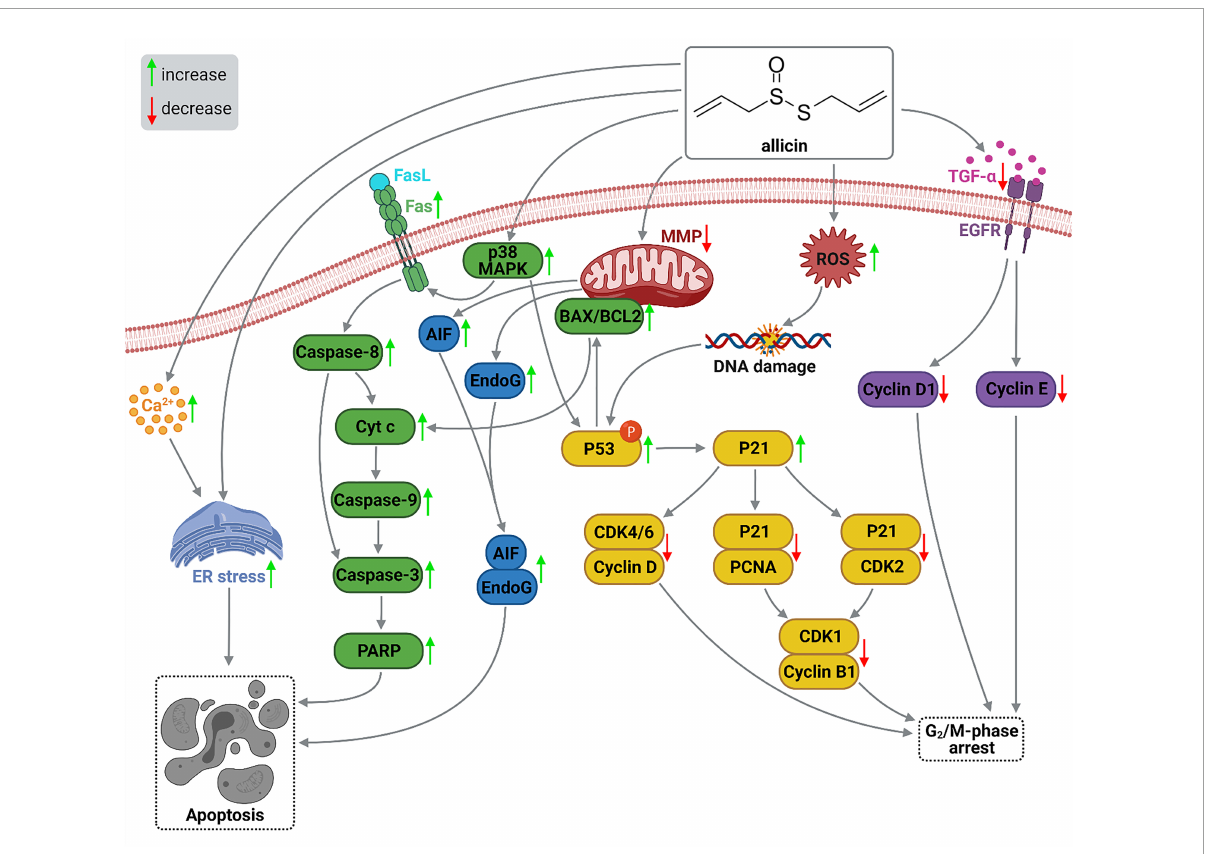
FIGURE3 Allicin-mediated apoptosis signaling pathways in gastric cancer cells. AIF, apoptosis induce factor; BAX, BCL2-associated X protein; BCL2, B-cell lymphoma 2 protein; CDK, cyclin-dependent kinase; Cyt c, cytochrome c; EGFR, epidermal growth factor receptor; EndoG, endonuclease G; ER, endoplasmic reticulum; Fas, apoptosis antigen 1 protein; FasL, Fas receptor ligand; MAPK, mitogen-activated protein kinase; MMP, mitochondrial membrane potential; PARP, poly ADP-ribose polymerase; PCNA, proliferating cell nuclear antigen; ROS, reactive oxygen species; TGF- α , transforming growth factor alpha (29). This figure was prepared with